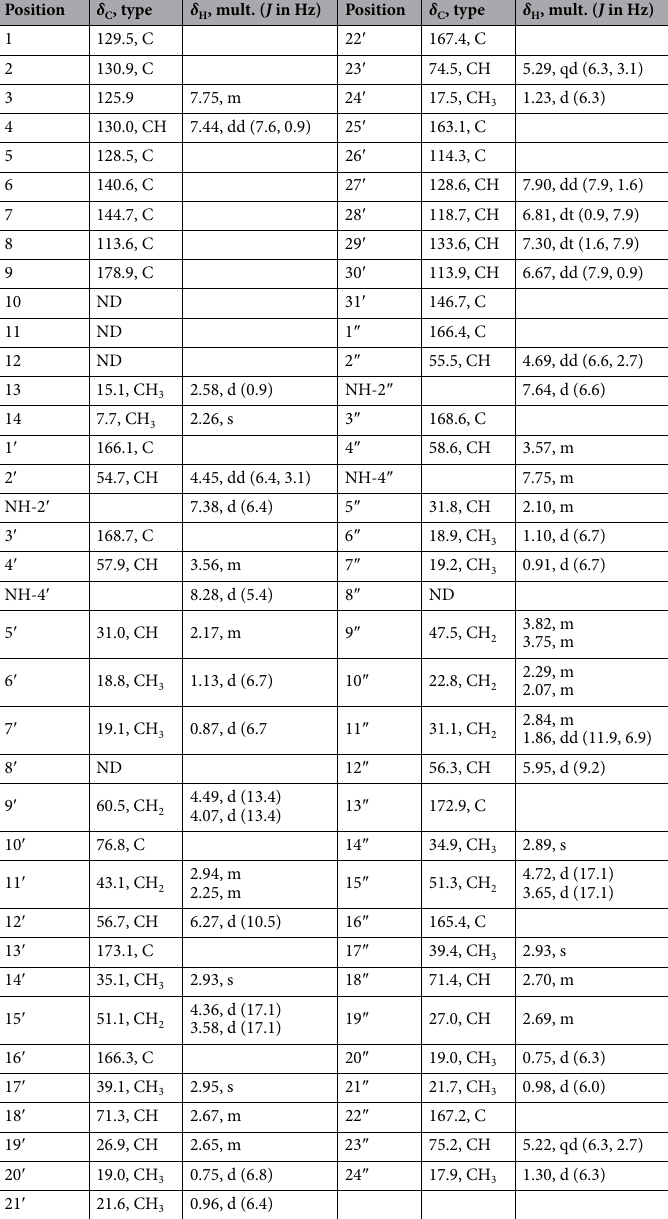
Table 2. 1 H and 13 C NMR data of 1 in CDCl 3 at 298 K. 1 H 850 MHz and 13 C NMR resonances inferred from HSQC and HMBC